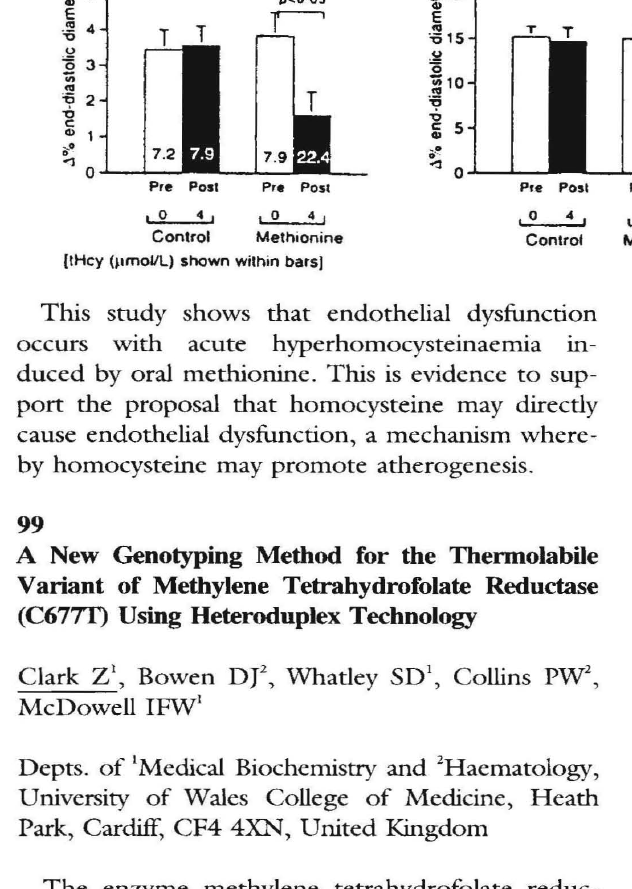
FOLATES IN TISSUES, TRANSPORT AND BINDING 100 Folate and Folate-dependent Enzymes Determined in Human and Rat Retina and Central Nervous System Martinasevic MK, Miller M and Tephly TR Methanol produces a characteristic intoxication syndrome in humans; metabolic acidosis, blind- Pteridines/ Vol. 8/ No.